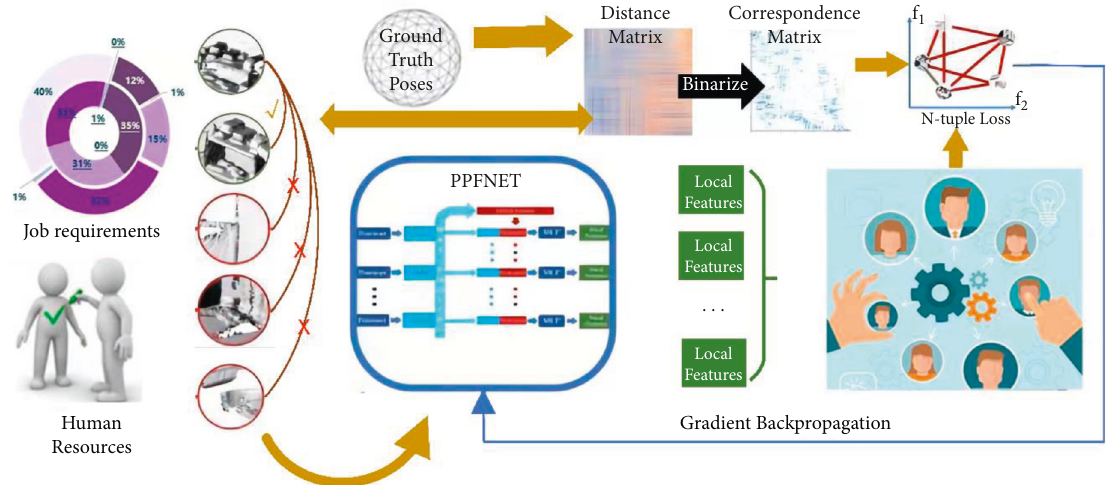
Figure 5: Schematic diagram of the HRM